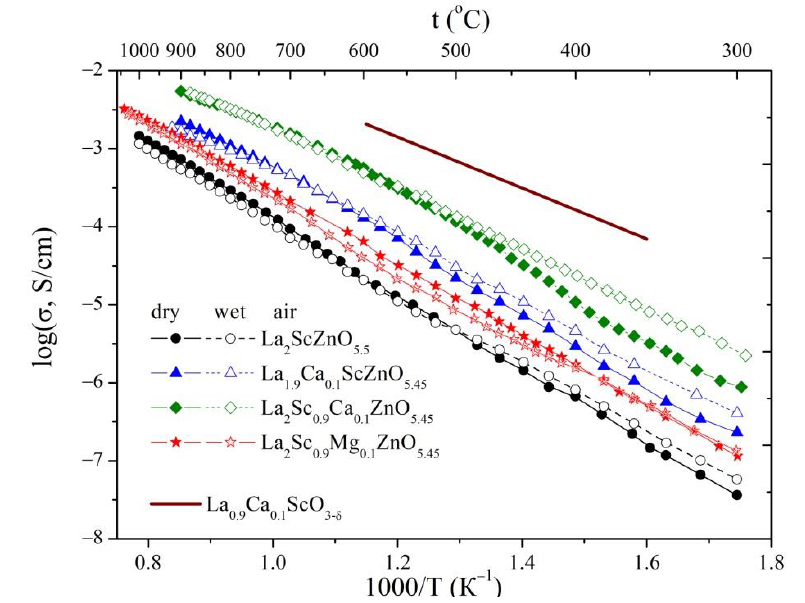
Figure 7. Temperature dependencies of the conductivities of La 2 ScZnO 5.5, La 2 Sc 0.9 Mg 0.1 ZnO 5.45 , La 2 Sc 0.9 Ca 0.1 ZnO 5.45 , La 1.9 Са 0.1 ScZnO 5.45 in comparison with La 0.9 Ca 0.1 ScO 3- δ [33].